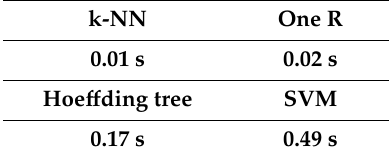
Table 5. Time to build models of all the experimented